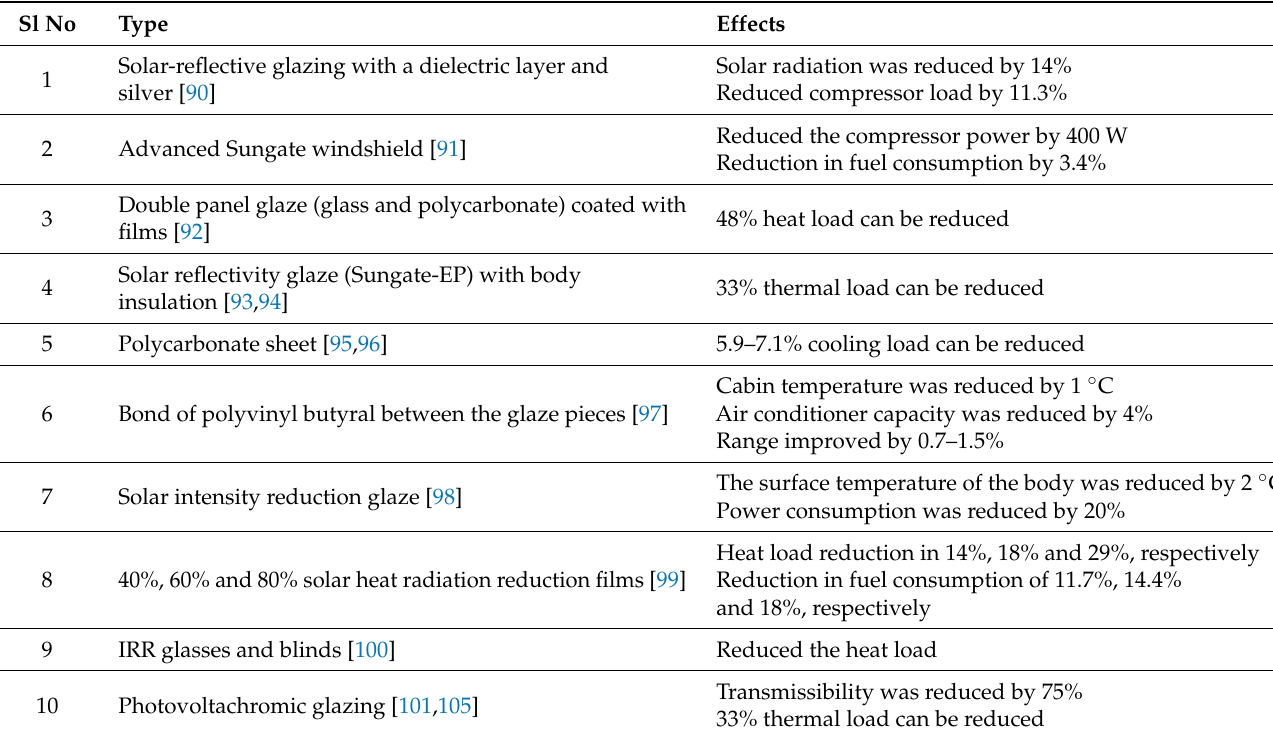
Table 6. Effect of different glazes in heat load.